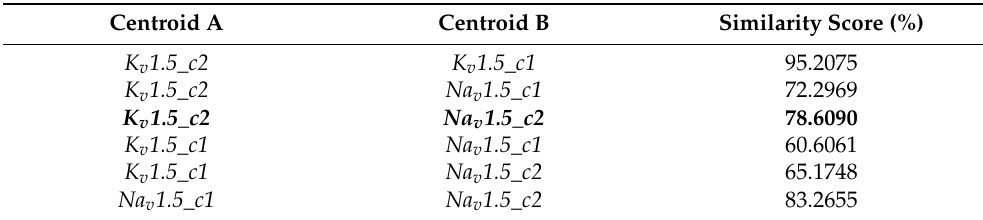
Table 3. Comparison of binding sites from centroids using PocketMatch and their corresponding values of similarity score (%) . For K v 1.5, centroid structures correspond to K v 1.5_c1 and K v 1.5_c2 from clusters 1 and 2, respectively. In the case of Na v 1.5, Na v 1.5_c1 and Na v 1.5_c2 correspond to the two centroids from respective clusters 1 and